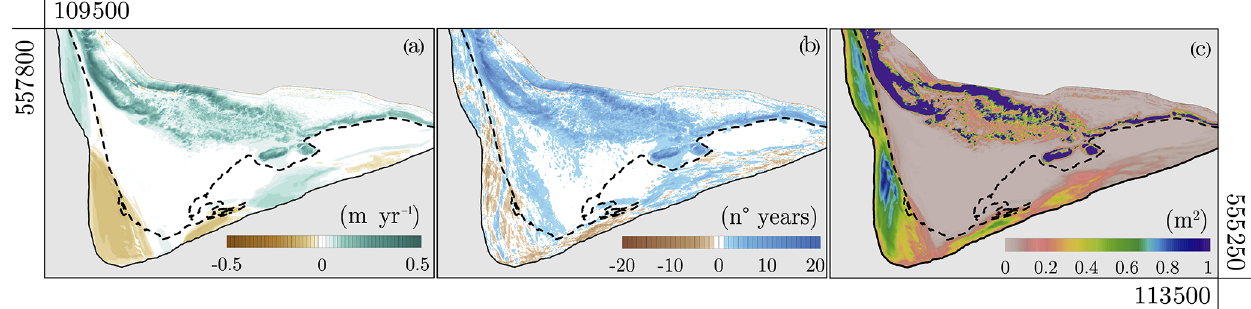
Figure 5. (a) Average annual elevation change based on lidar data from 1997 up to 2017. Dashed lines show the average position of the MSHTL. (b) Net number of years where accretion/erosion occurrences from the difference maps were greater than 0.16m. Negative values mean that the location had more erosive years than accretive, whereas positive values mean that the location had more accretive years than erosive. (c) Variance in the